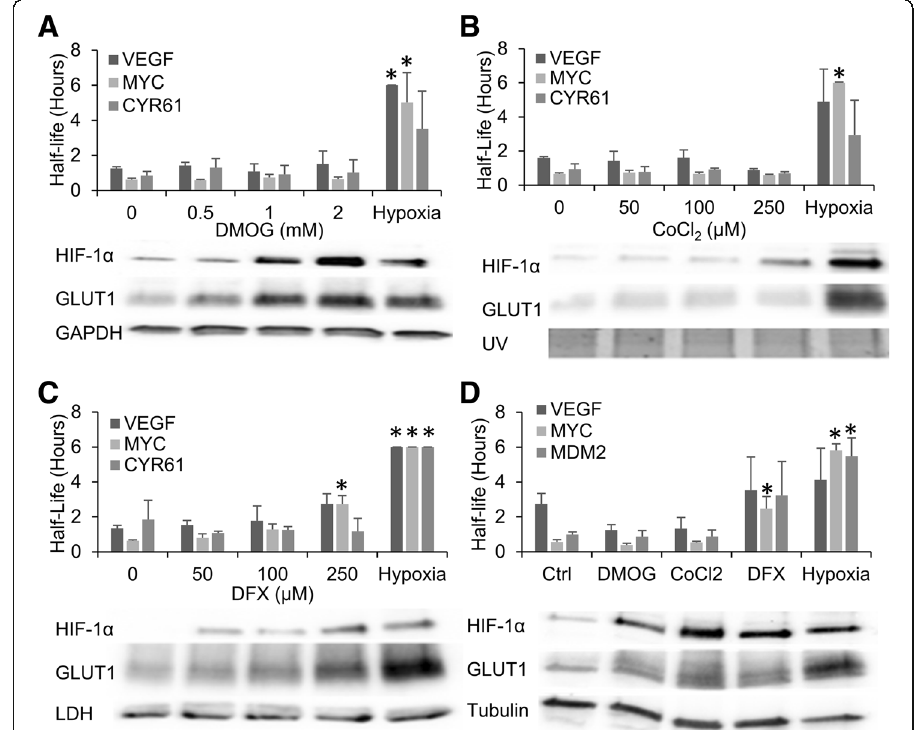
Fig. 1 mRNA stability is induced by hypoxic exposure but not treatment with hypoxic mimetics. HEK293T ( a-c ) or C6 ( d ) cells exposed to 24 h of Normoxia and either 1% Oxygen (Hypoxia) or the indicated concentrations of DMOG ( a ), CoCl 2 ( b ), or DFX ( c ) in the presence 1 g/L glucose before being treated with actinomycin D for 0, 1 or 2 h. mRNA levels of VEFG, MYC, and CYR61 were determined via qPCR, normalized to GAPDH and 0 h time point and half-lives determined. Protein was analyzed via western blotting to confirm treatments had desired effect of HIF induction. Data represents average of N = 3 (HEK293T) or 4 (C6) ± SD for each condition. * P ≤ 0.05 from respective Normoxic (0, Ctrl)